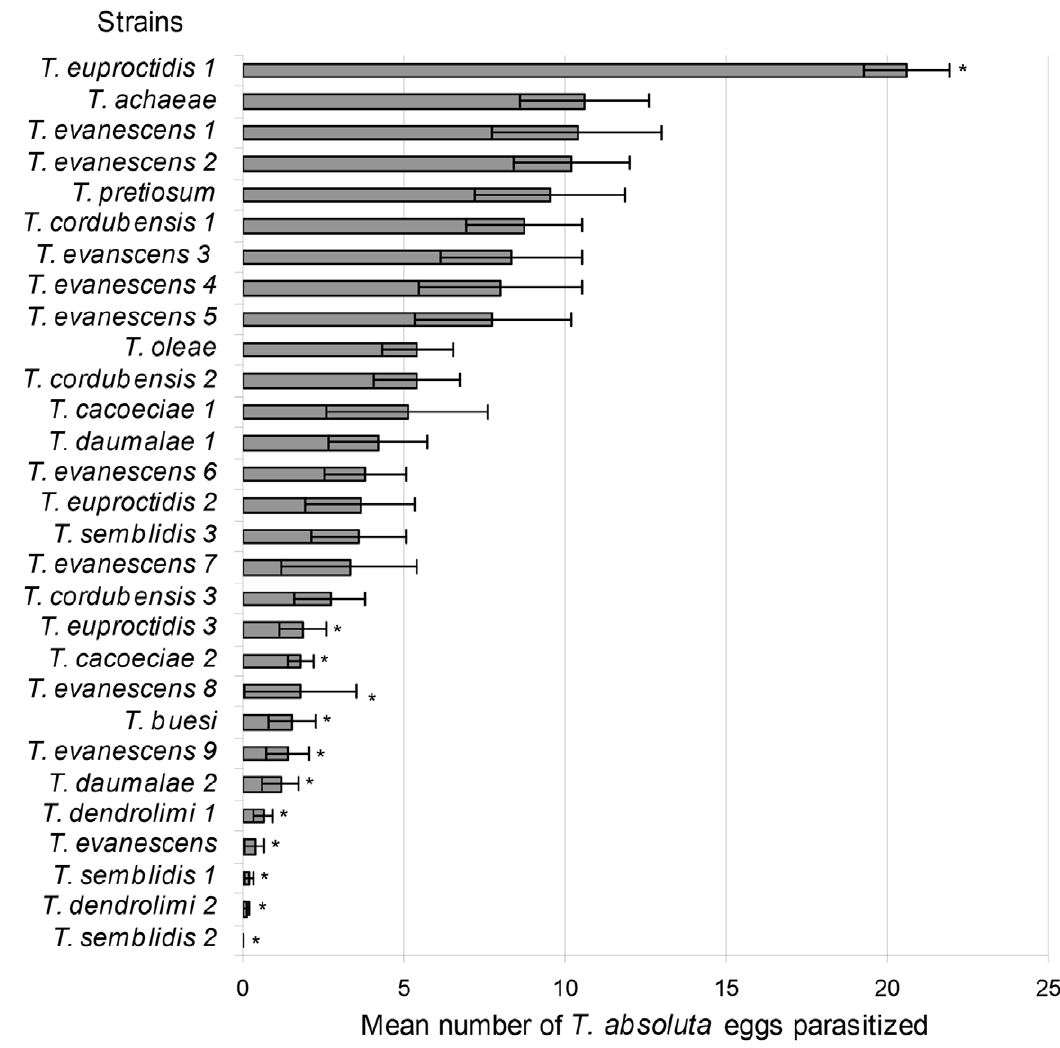
Figure 1. Parasitism of Tuta absoluta eggs under laboratory conditions. Mean ( 6 SEM) number of parasitized T. absoluta eggs per Trichogramma strain in laboratory screening tubes on tomato leaflets . Strains with an asterisk are significantly different from Trichogramma achaeae at P , 0.05 level (GLM analysis). One strain of Trichogramma , Trichogramma euproctidis 1, was significantly more efficient than T. achaeae .